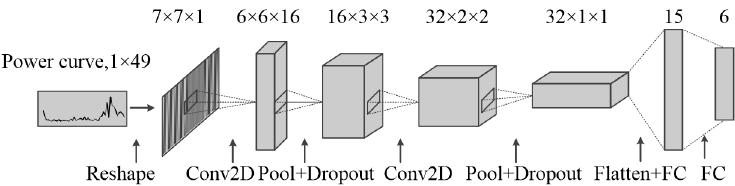
Figure 2. The structure and parameters of the convolutional neural network (CNN) for electricity theft detection.